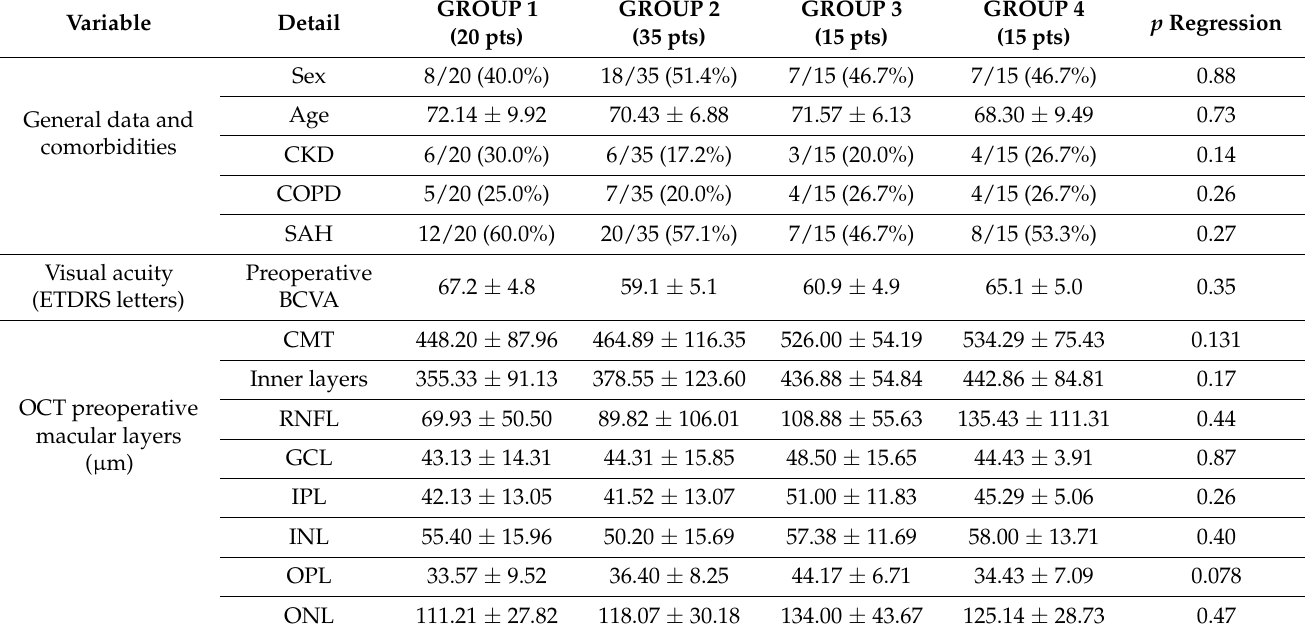
Table 1. Differences in anamnestic and tomographic variables between the 4 VA trend groups. Results from multinomial logistic regression are shown. BCVA = best corrected visual acuity; CKD = chronic kidney disease; CMT = central macular thickness; COPD = chronic obstructive pulmonary disease; GCL = ganglion cell layer; INL = inner nuclear layer; IPL = inner plexiform layer; OCT = optic coherence tomography; ONL = outer nuclear layer; OPL = outer plexiform layer; RNFL = retinal nerve fiber layer; SAH = systemic arterial